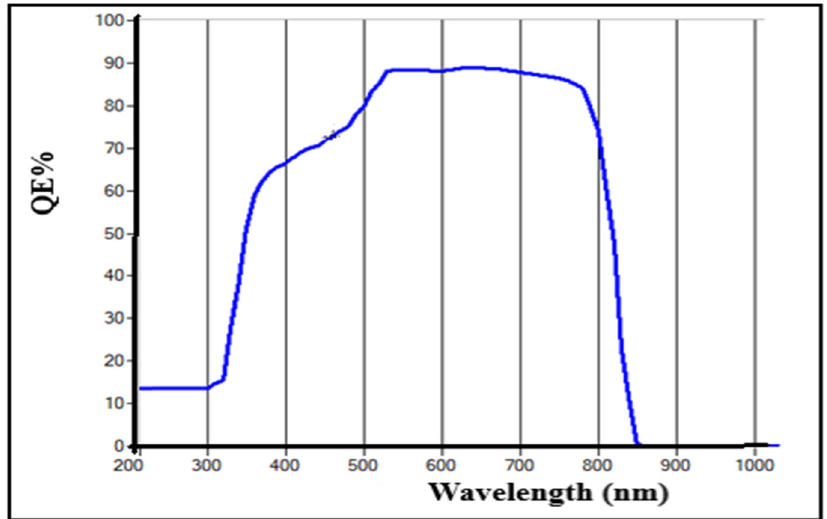
Figure 10. Quantum efficiency ( QE , %) outputs for the thin film (CdTe N A = 2 × 10 15 cm − 3 , ZnSe N D = 1 × 10 22 cm − 3 and SnO 2 N D = 1 × 10 22 cm − 3 ), at T = 300 K.